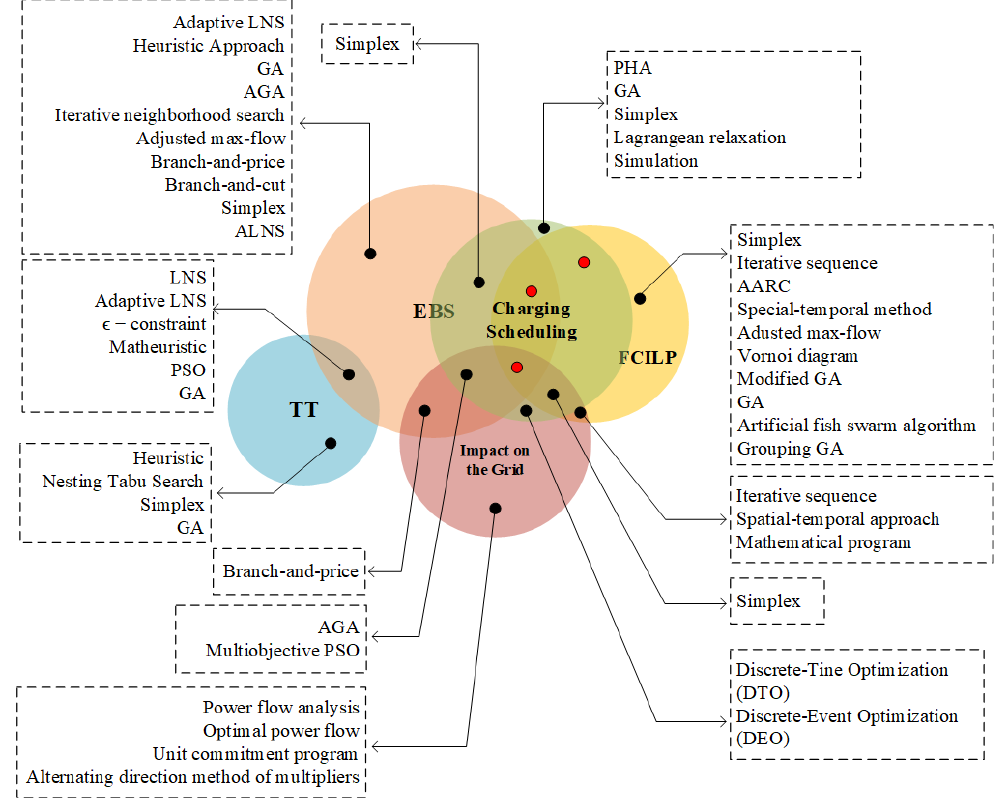
Figure 8. Integration of EB optimization problems and possibilities of future